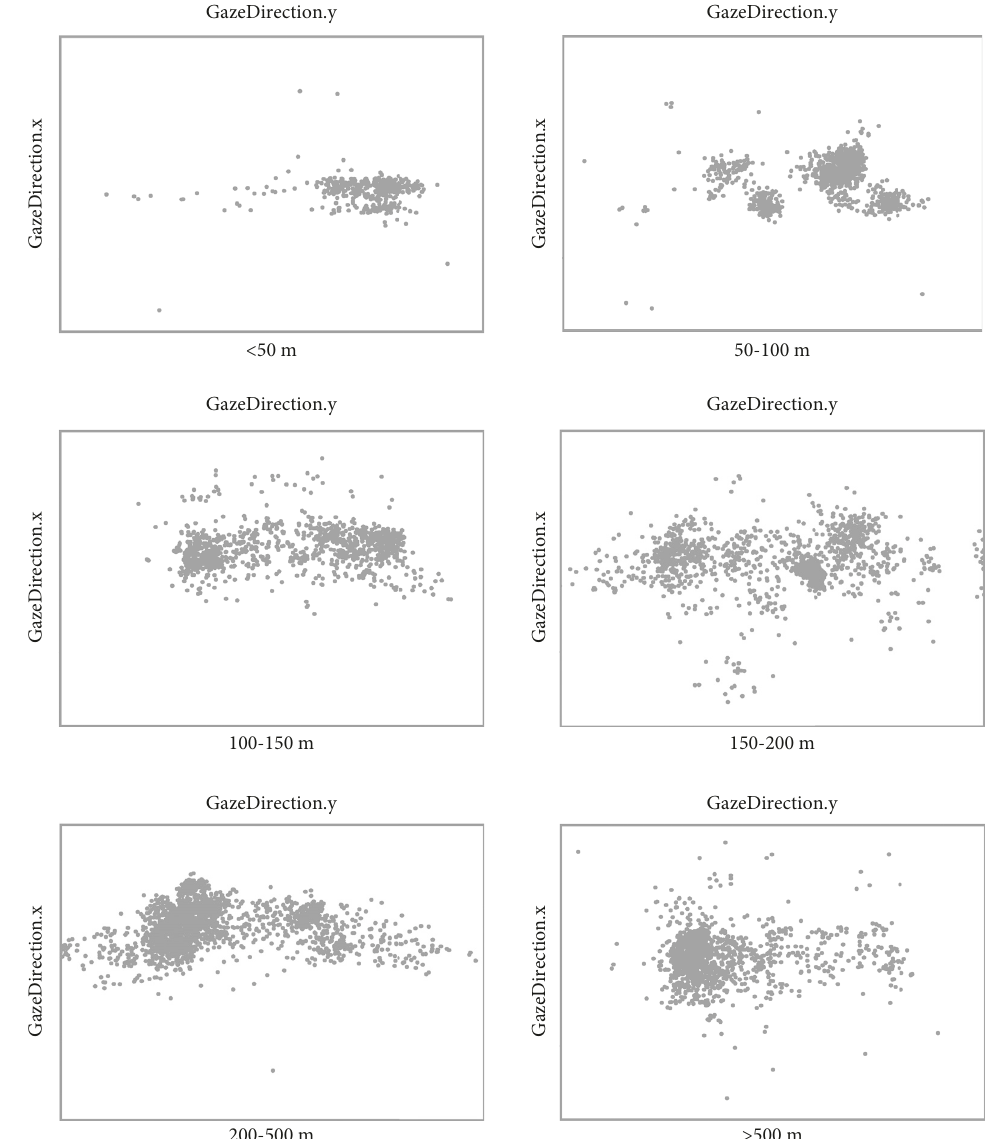
Figure 1: Normalization results of the center of gravity of the driver’s lane changing gaze area under different